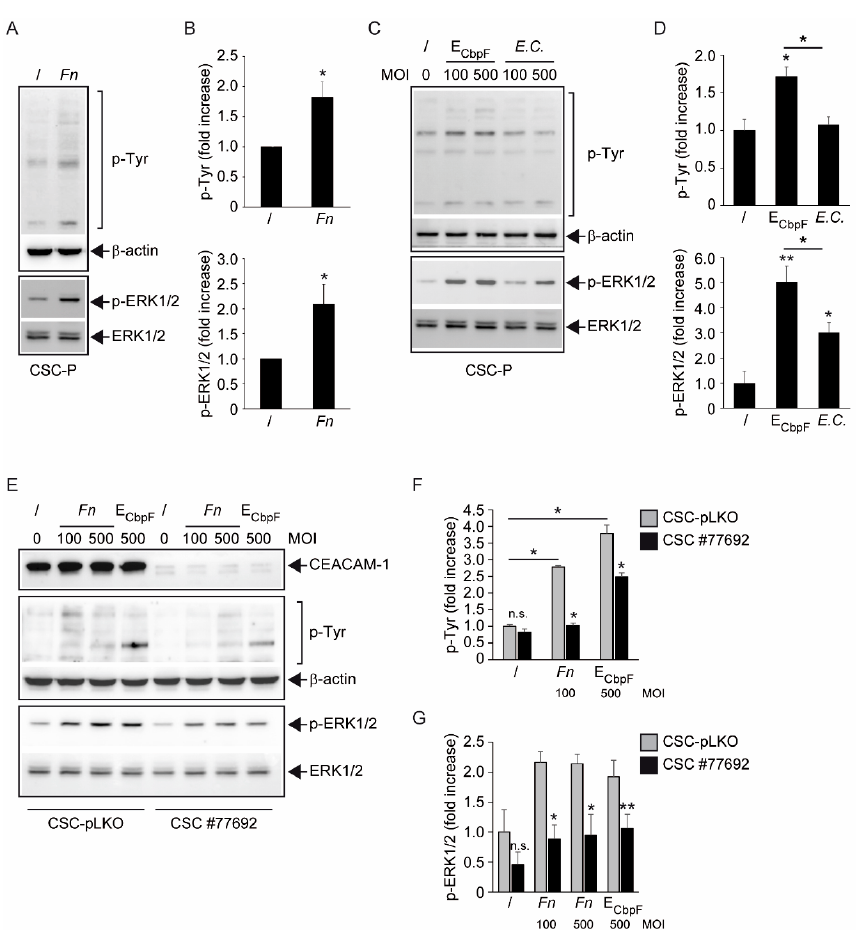
Figure 4. Fn triggers CEACAM1-dependent protein tyrosine phosphorylation signals in spheroidal CSCs. ( A ) Representative Western blot analysis of total homogenates from control (/) and Fn -stimulated ( Fn ) CSC-P. Cells were stimulated for 20 min with 200 MOI Fn in serum-free RPMI. Membranes were stained with antisera directed against tyrosine-phosphorylated proteins (upper) and phosphor-ERK1/2 (Thr202/Tyr204) (lower). Immunoblots for β -actin and total ERK1/2 are reported as a control for equal protein loading. Relevant patterns and bands are indicated by braces and arrows, respectively. ( B ) Lane (pTyr, range 60–140 kD) and band (pERK) quantitations from 7–8 independent experiments as in ( A ). Represented values are the mean fold-induction ± S.E.M. Statistics were determined by the Wilcoxon signed-rank test (* p < 0.02). ( C , D ) Representative immunoblots and relative lane/band quantitations of tyrosine-phosphorylated proteins (upper) and phospho-ERK1/2 (Thr202/Tyr204) (lower) in homogenates of CSCs treated with CbpF-expressing E. coli (E CbpF ), the non-recombinant control strain ( E.C. ), or no bacteria (/). MOI (100 or 500) are indicated. Loading controls are as in ( A ). Values are the mean ± S.E.M. of band intensities from multiple (range 2 to 6) experiments, normalized to the mean of the untreated samples. Statistics (* p < 0.05; ** p < 0.01 vs. untreated; black line = EcbpF vs. E.C. ) were determined by ANOVA (Tukey HSD post hoc test). ( E ) Immunoblot analysis of protein phosphorylation signals in CSC cells depleted of CEACAM-1 (#77692) and their mock-infected (pLKO) controls. Cells were stimulated as in ( A ) with the indicated MOI of Fn or E CbpF . Stainings and loading controls as in A and C. Successful silencing of CEACAM1 in #77692 cells was verified by anti-CEACAM1 immunoblotting (top panel). ( F , G ) Lane/band densitometry from multiple (2 to 3) experiments. Values are the mean ± S.E.M of the band intensities, normalized across the treatments to the mean of the pLKO (/) sample. Statistics were performed on non-normalized values by either two-way ANOVA (panel ( F ), * p < 0.01 (#77692 vs. pLKO; pLKO treated vs. untreated), or a paired Student’s t -test (panel ( G ), ** p < 0.005 vs. pLKO; * p < 0.05 vs. pLKO). n.s. denotes